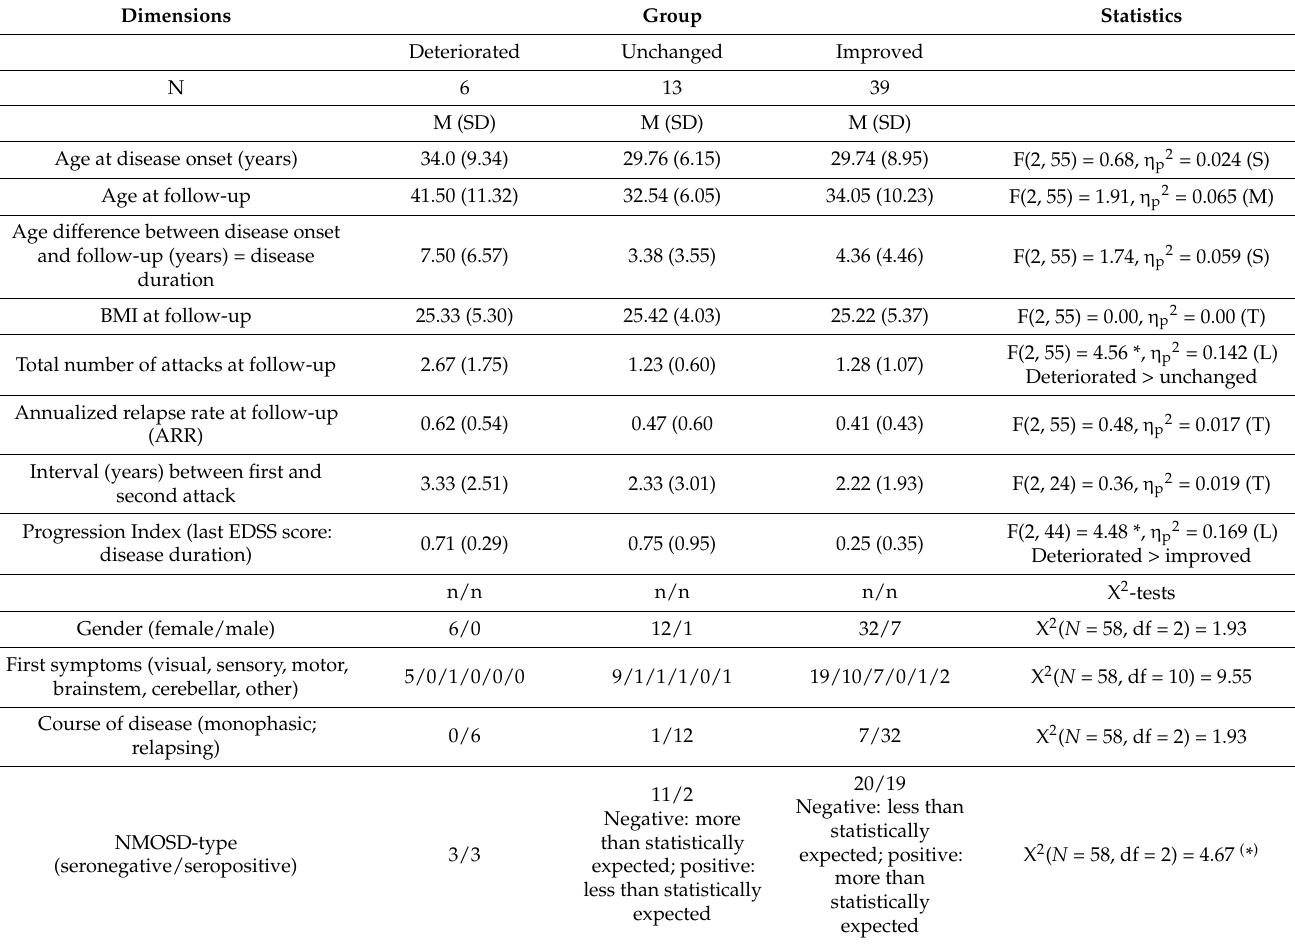
Table 3. Overview of descriptive and inferential statistical indices of sociodemographic, disease- related and treatment-related information, separately for the three groups of improving ( n = 39), unchanged ( n = 13), and deteriorating ( n =